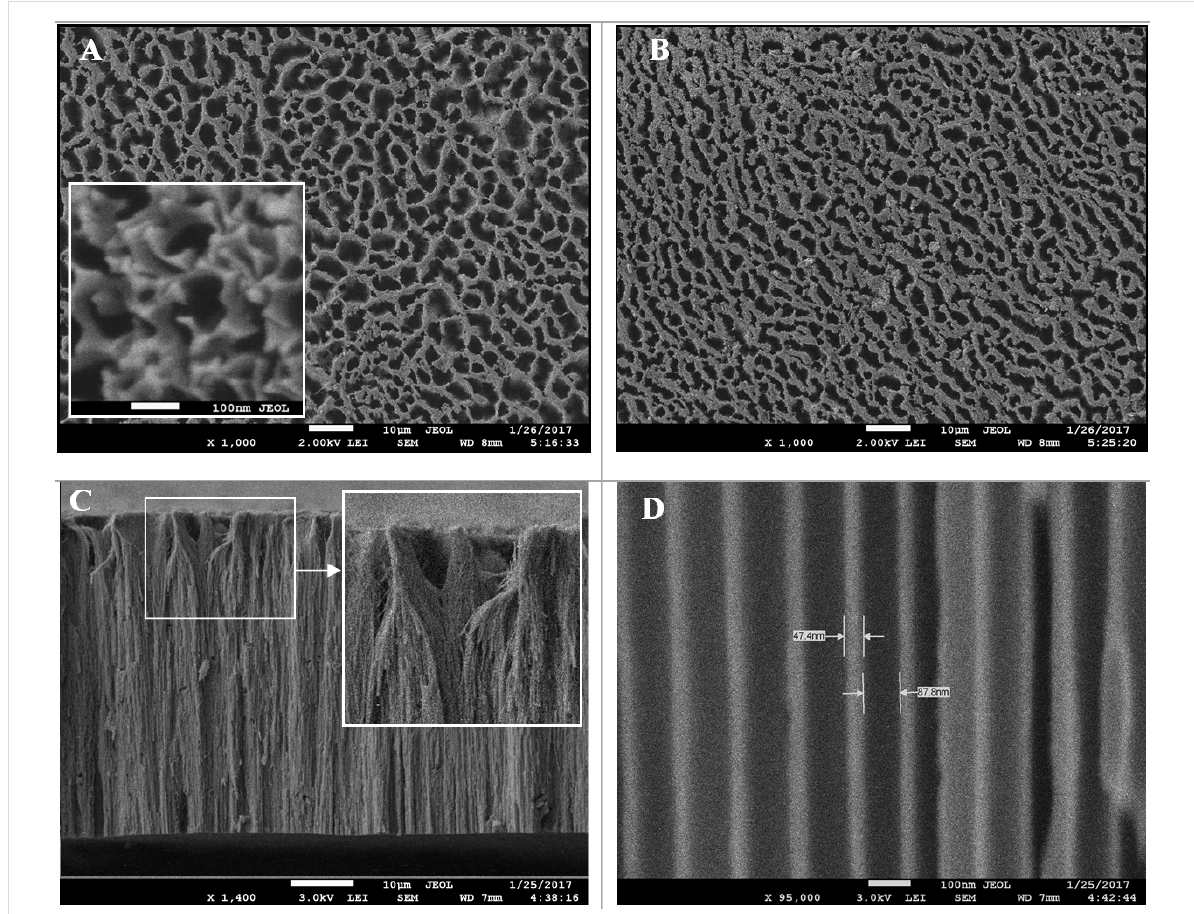
Figure 4: SEM images of the outer (A) and back (B) surfaces and cross-sections (C, D) of the sample (type I) after a complete etching of the barrier layer at the bottom of the oxide pores.